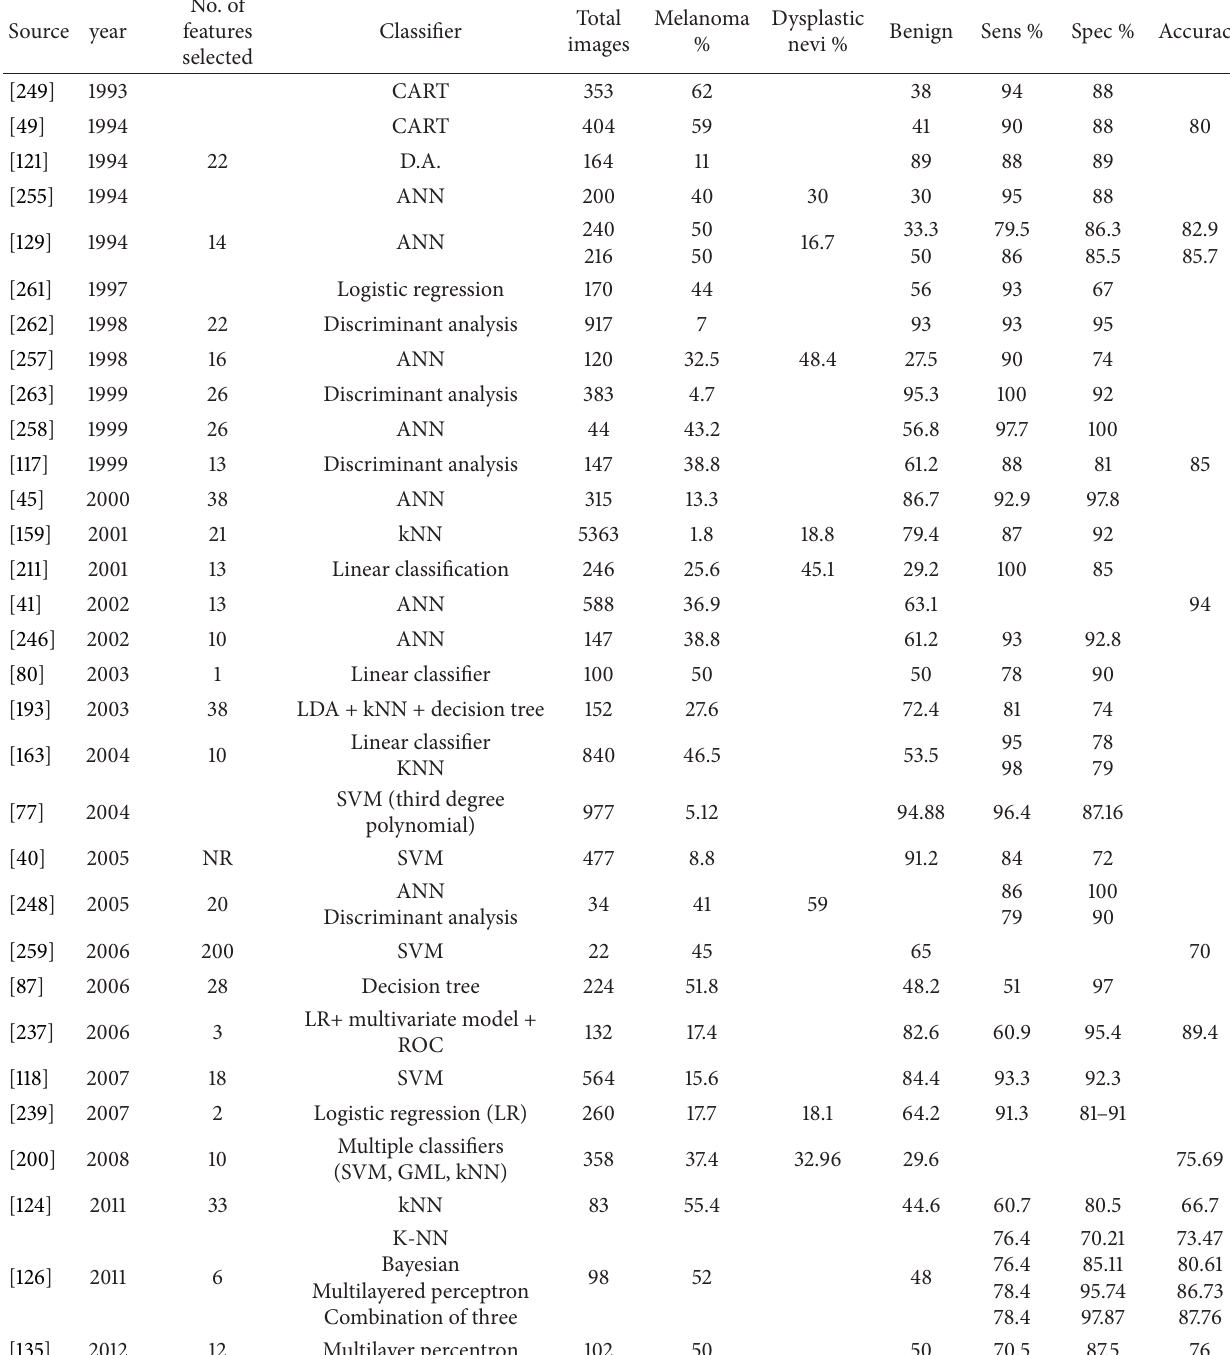
Table 5: Summary of classification performance of some skin cancer detection